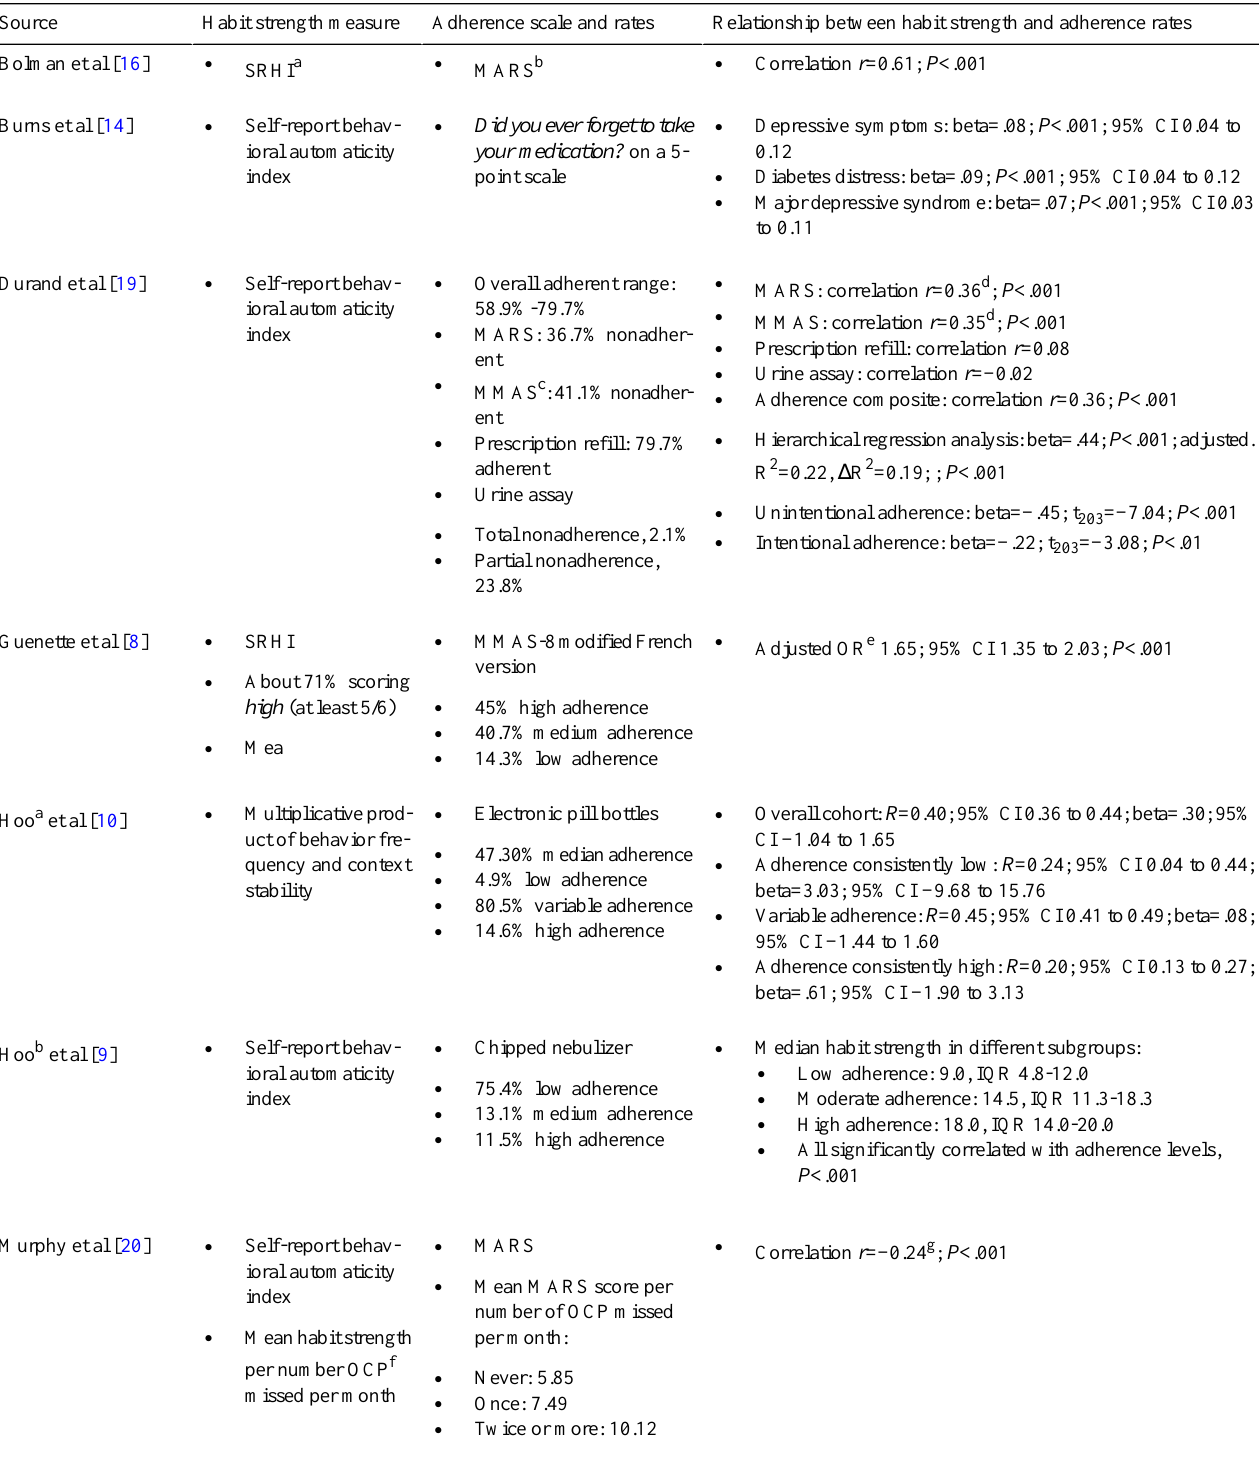
Table 2. Summary of habit strength, medication adherence measures, and outcomes in the included